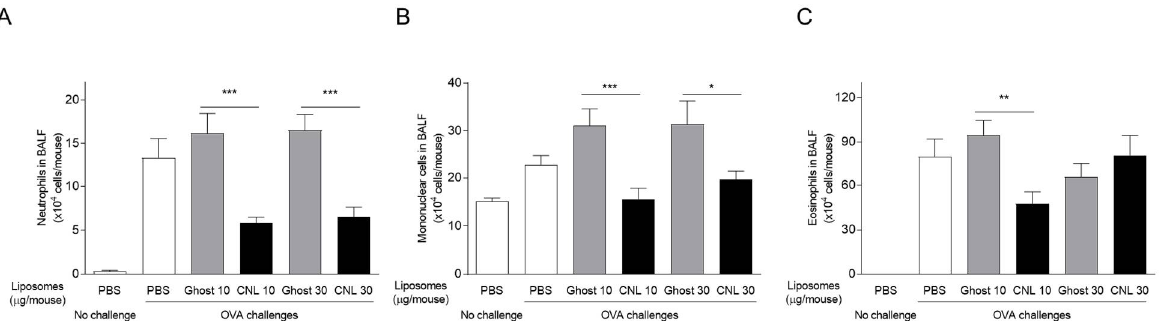
Figure 2. Effects of ceramide nanoliposomes (CNL) on leukocyte infiltration to BAL fluids in asthmatic mice. OVA-sensitized mice were challenged with OVA-free PBS or OVA. OVA-challenged asthmatic mice were treated with liposome-free PBS, ceramide-free ghost or CNL. The numbers of mononuclear cells ( A ), neutrophils ( B ), and eosinophils ( C ) in BAL fluids were determined by coulter counter and Diff-Quik staining. Data are shown as mean ± S.E. ( n = 10–13). * p < 0.05, ** p < 0.01, *** p < 0.001 compared to the Ghost group.